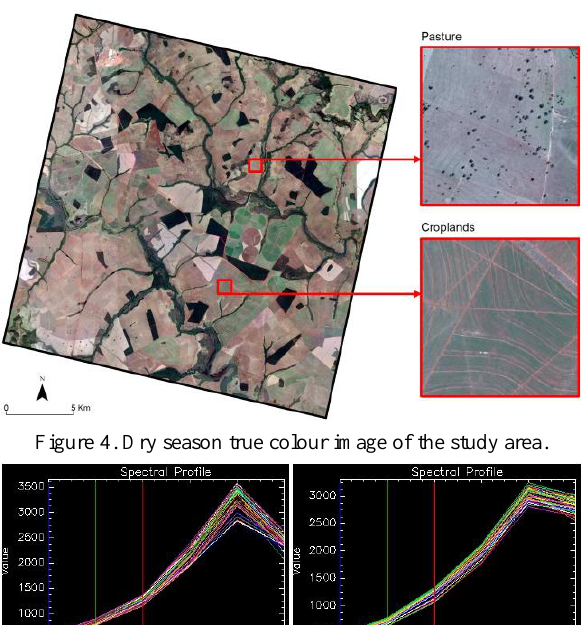
Figure 5. Spectral profiles of pasture (left) and cropland